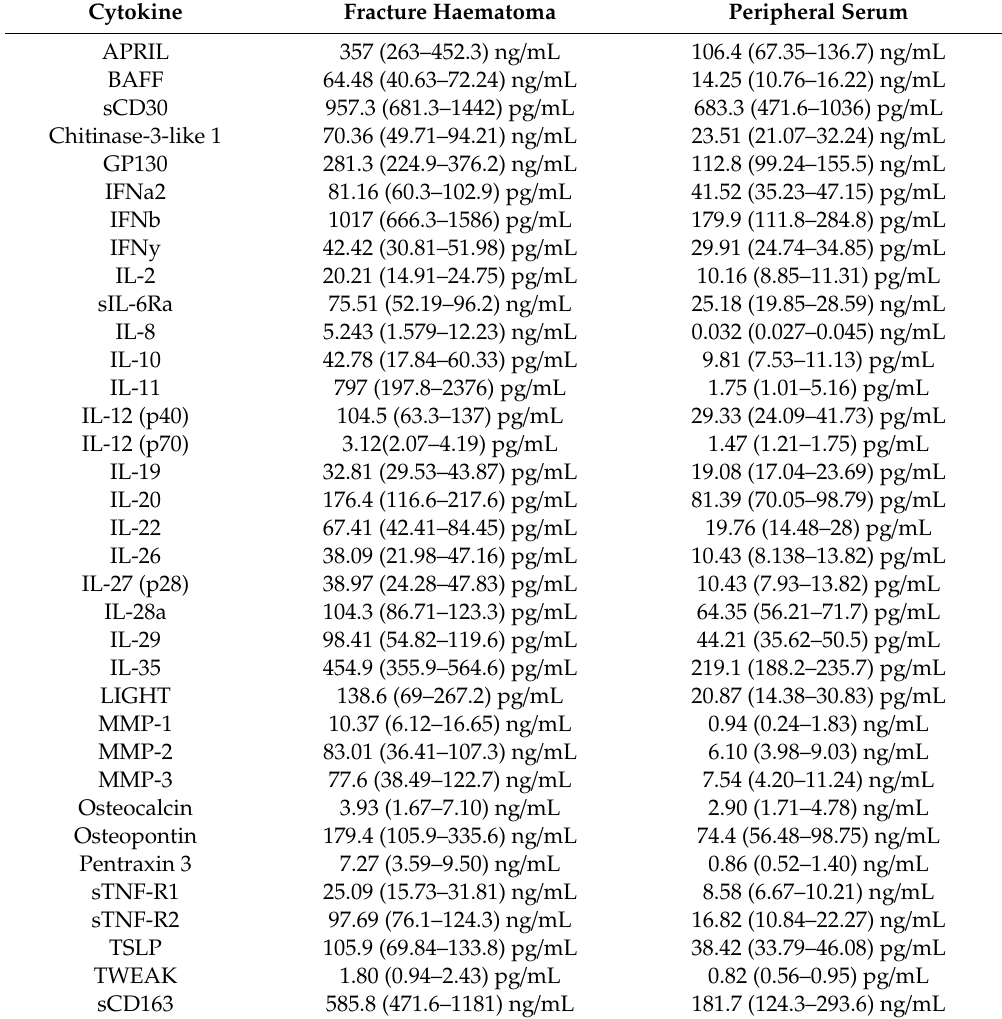
Table 2. The cytokine concentrations measures in the study. Mean values in fracture haematoma and peripheral